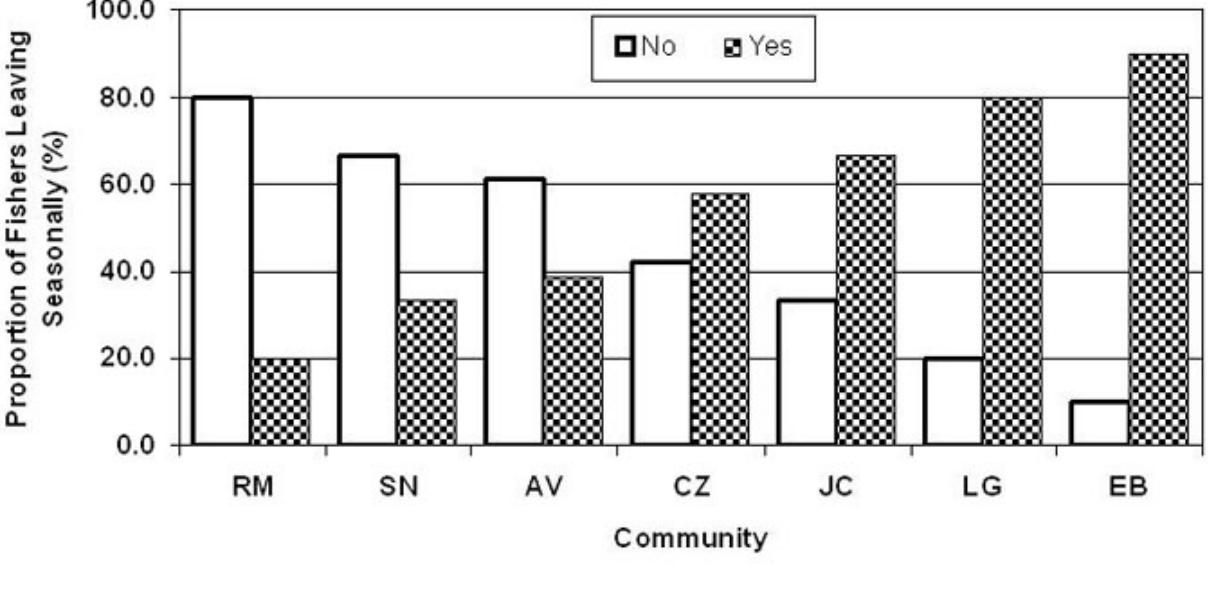
Fig. 3. Fishers who leave their communities temporarily to access fish resources. Ramadita (RM), San Nicolás (SN) and Agua Verde (AV) communities experience lower resource scarcity than Colonia Zaragoza (CZ), Juncalito (JC), Ligüí (LG), and Ensenada Blanca (EB)